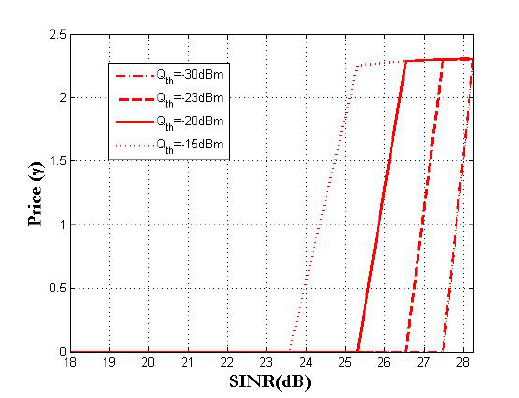
Figure 6. Price variation vs. SINR.